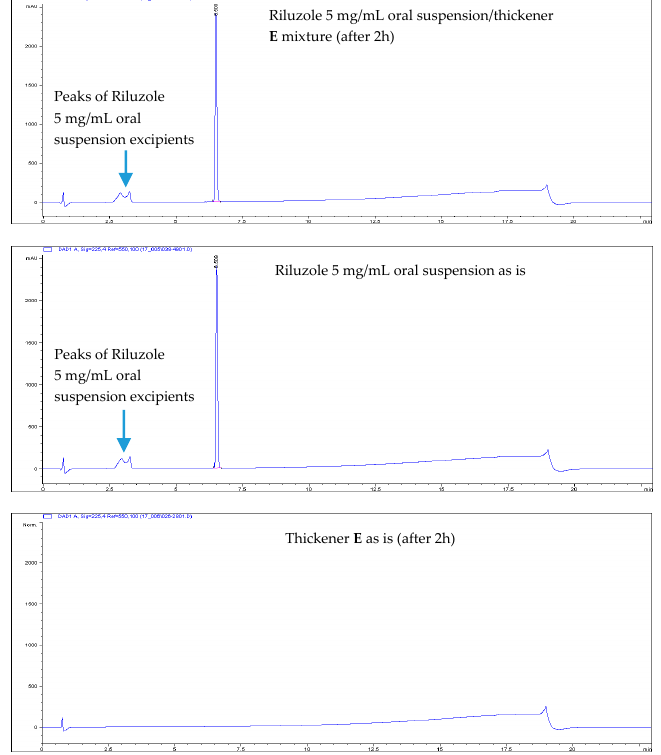
Figure 5 Figure 5. Comparison of chromatograms: Riluzole 5 mg / mL oral suspension / thickener E mixture (after 2 h); Riluzole 5 mg / mL oral suspension as is and Thickener E as is (after 2